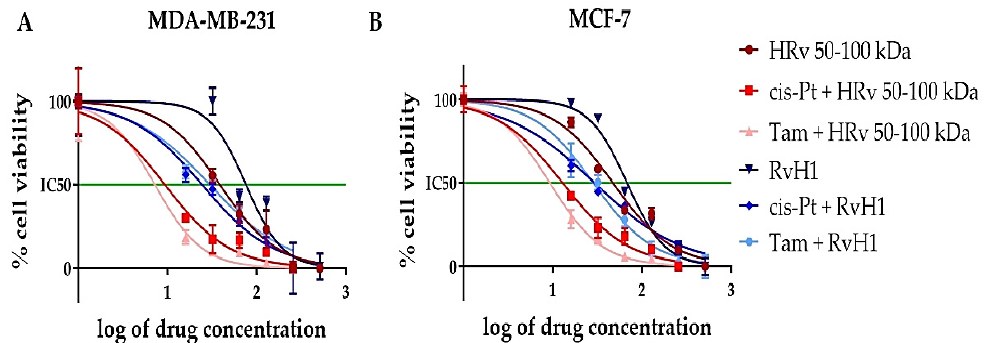
Figure 4. Dose–response curves of cancerous cells treated with HRv 50–100 kDa (dark red line) alone, in combination with cisplatin (bright red line) or tamoxifen (pink line), or RvH1 alone (dark blue line), in combination with cisplatin (bright blue line) or tamoxifen (light blue line). Logarithms of the concentrations of the substances, alone and in combinations, are plotted against cell viability in %. ( A ) MDA-MB-231 treated cells; ( B ) MCF-7 treated cells. Table 4. Parameters of the combination index analysis in CompuSyn ® for MCF-7 and MDA-MB-231 cells treated with hemolymph fraction from R. venosa with Mw 50–100 kDa at a constant concentration corresponding to IC 25 combined with cisplatin or tamoxifen in serial dilutions from 16 to 512 µ M. The graded symbols for column “Combined effect” are designated as: Antago- nism (1.45–3.3) = ---; Moderate antagonism (1.20–1.45) = --; Slight antagonism (1.10–1.20) = -; Nearly additive (0.90–1.10); Slight synergism (0.85–0.90) = +; Moderate synergism (0.7–0.85) = ++;